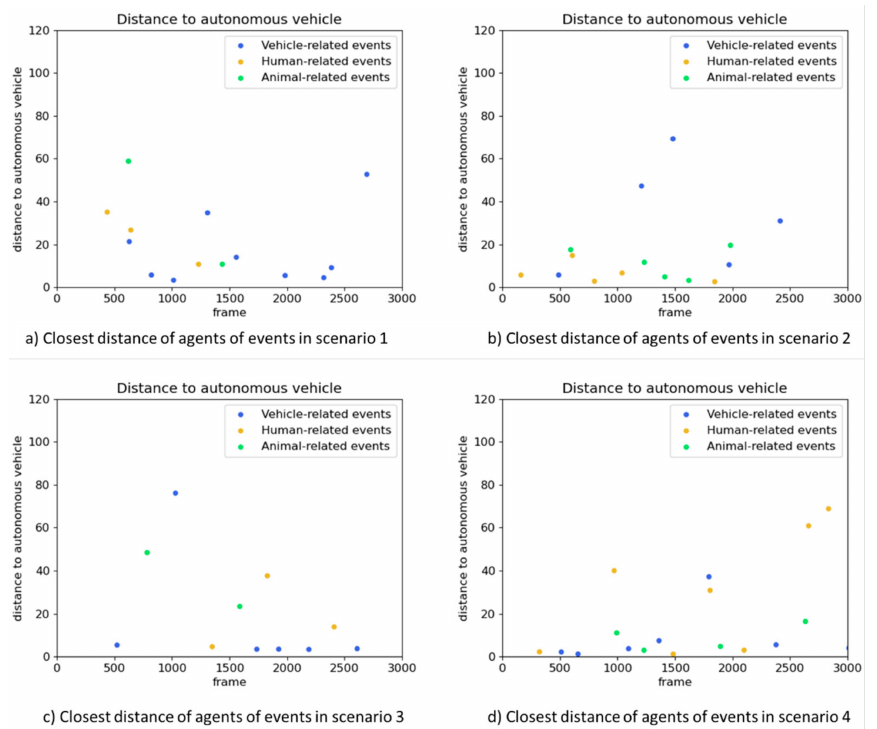
Figure 23. The analysis of distance between autonomous vehicle and agents in events of four scenarios in Figure